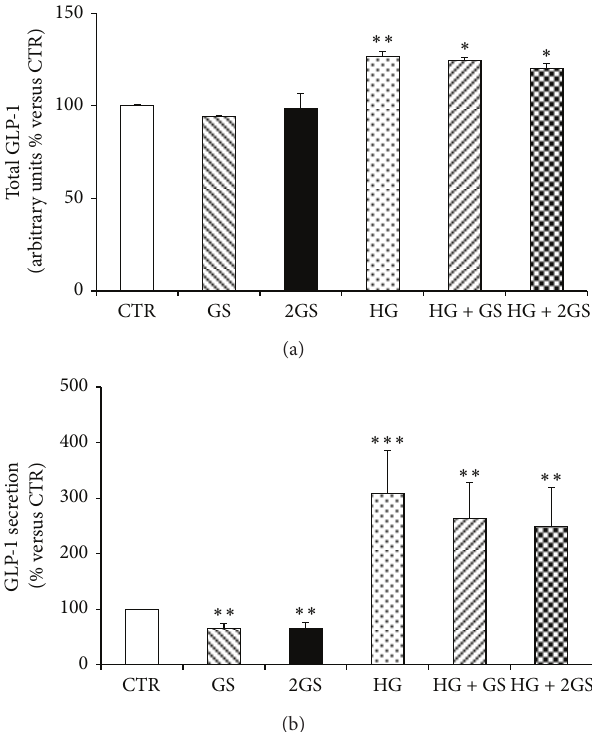
Figure3:HGincreasesGLP-1totalproductionandrelease.Levelsof total GLP-1 production (a) (calculated as the sum of the supernatant andcellcontentofGLP-1)andGLP-1released(b)inthesupernatants were shown. Data are expressed as mean ± SE ( 𝑛 = 5 ). ∗ 𝑃 < 0.05 , ∗∗ 𝑃 < 0.01 , and ∗∗∗ 𝑃 < 0.001 versus CTR.